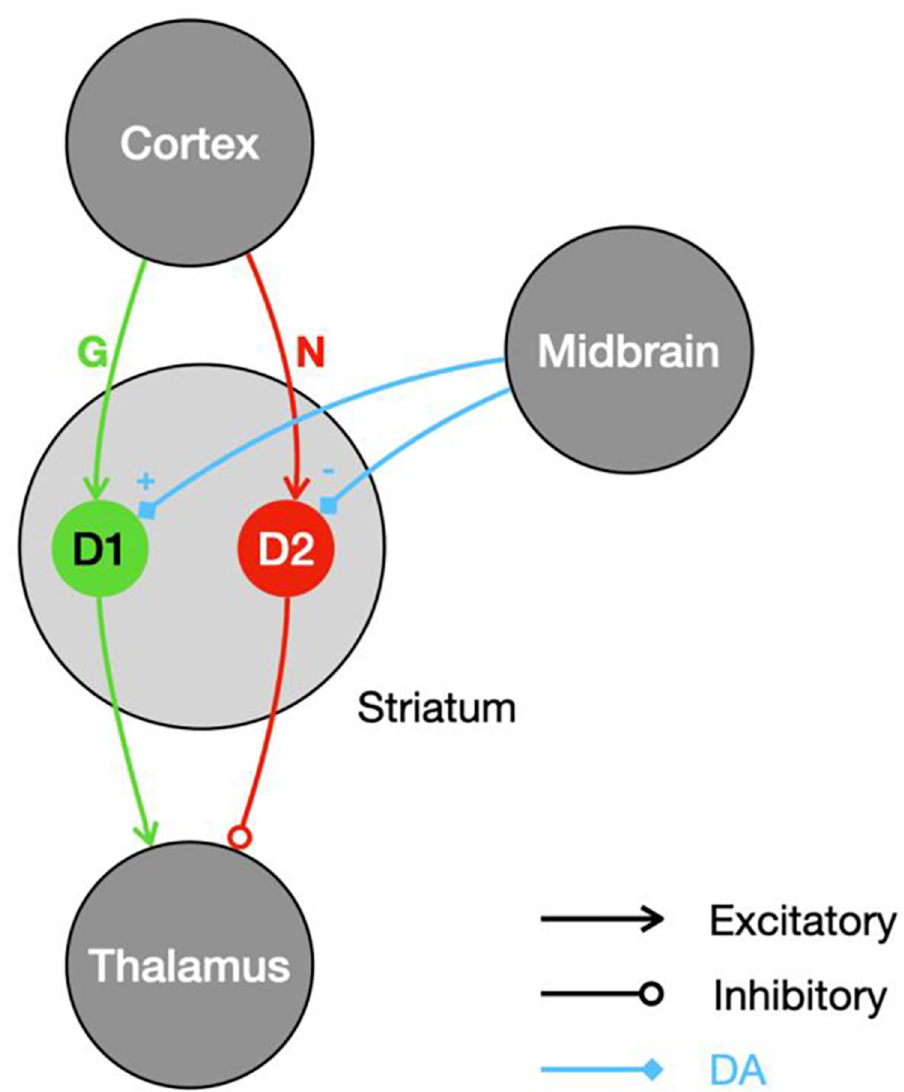
Fig 1. The simplified basal ganglia circuit. Selected nuclei and connections are shown as circles and arrows. Green connections correspond to the direct pathway; red connections correspond to the indirect pathway. Dopamine projections are shown in